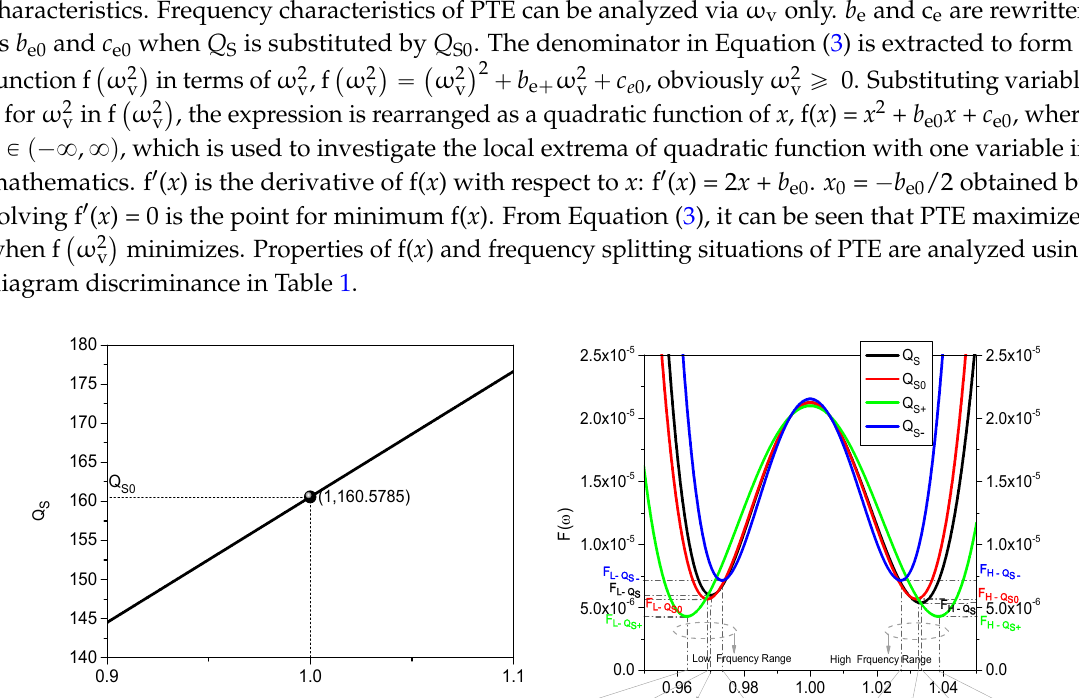
α 2 = α 2 = 1, β 2 = 0.5 and β 2 = 5. 21 31 21 31